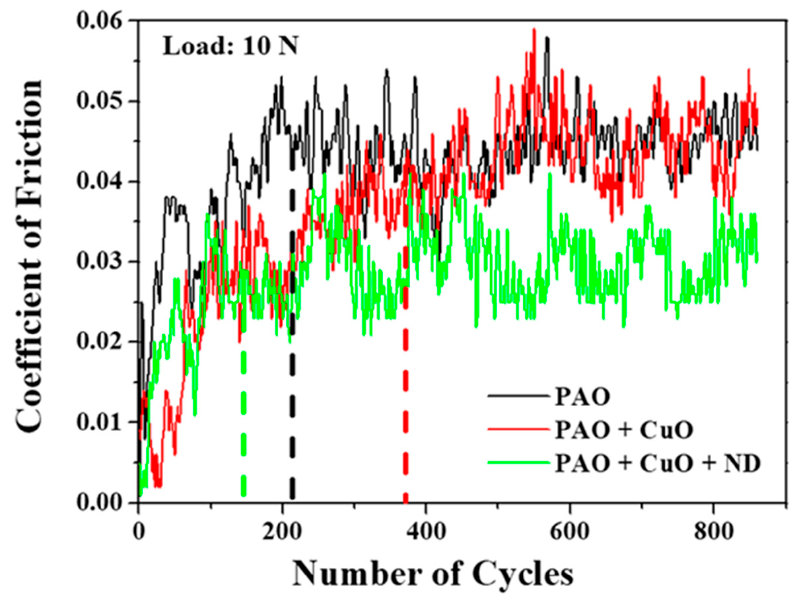
Figure 12. Coefficient of friction as a function of the number of cycles for PAO base oil, PAO + CuO and PAO + CuO + ND nanolubricants (tests conducted at 10 N load). The vertical dotted lines intersecting the x -axis indicate the onset of steady state condition.